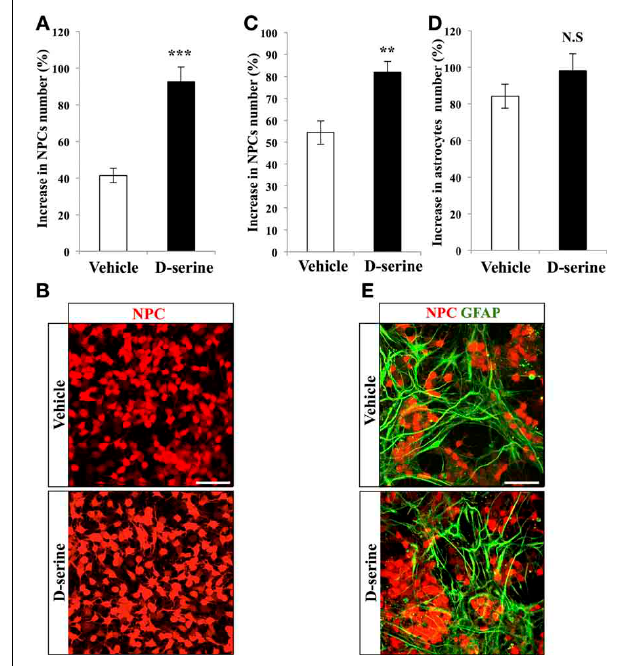
FIGURE 4 | D-serine increased the number of NPCs in vitro . (A) Histogram of the increase in NPCs number (% of the number of plated cells), upon treatment with D-serine or vehicle. (B) Confocal maximal projection micrographs of RFP-expressing NPCs for each condition. (C,D) Histograms showing the proportion of increase in NPCs (C) and in GFAP-expressing astrocytes (D) in co-cultures treated with D-serine or vehicle. (E) Confocal maximal projection micrographs of NPCs-Astrocytes co-cultures in the two conditions. Each value represents the mean ± SEM; post-hoc bilateral Student’s t - test, ( ∗∗∗ p < 0 . 001, ∗∗ p < 0 . 01), N.S., non-significant ( p > 0 . 05). Scale bars: 100 μ